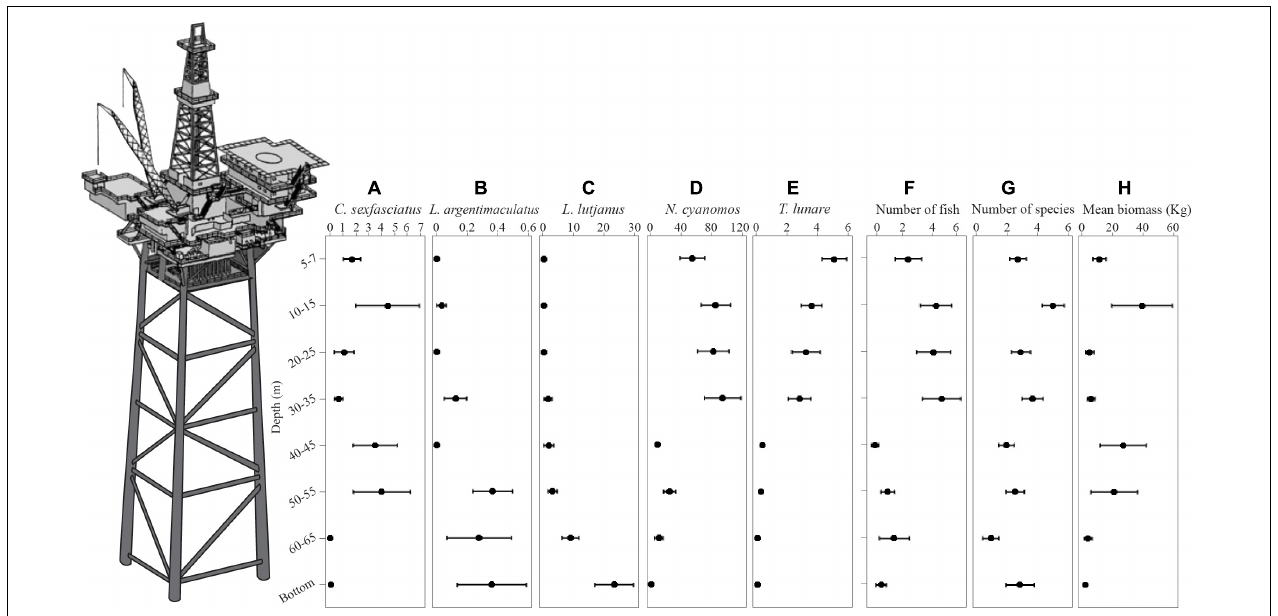
FIGURE 3 | Plots of the mean abundance with depth of C. sexfasciatus (A) , L. argentimaculatus (B) , L. lutjanus (C) , N. cyanomos (D) , T. lunare (E) , the number of fish (F) , the number of species (G) , and the mean biomass (H) . Errors bars = ± 1 SE. This is a stylized pictorial of a platform. At the time of surveys only boat landing decks and navigational beacons remained above